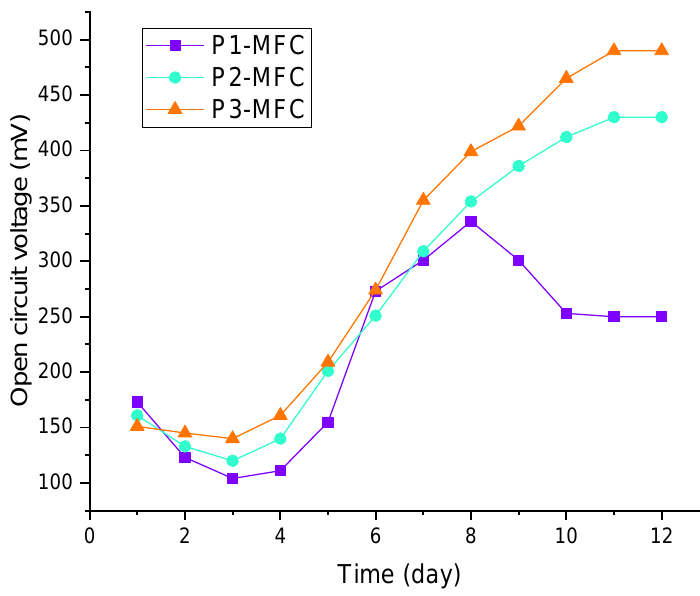
Figure 1. Daily measured OCV values of MFCs.